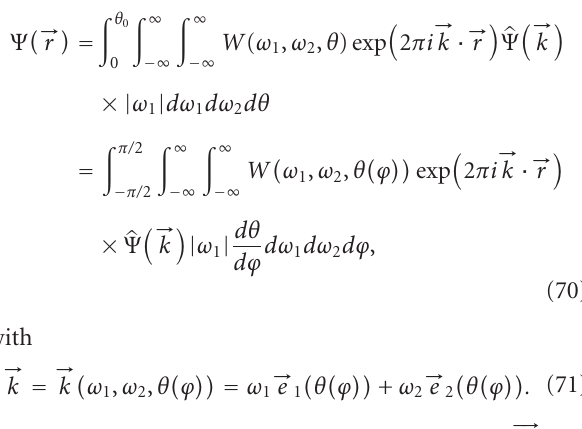
π/ 4, ϕ 3 = 0, ϕ 4 = π/ 4 and ϕ 5 = π/ 2, respectively. Note −−→ −−→ that the initial position Π ( OS 1 ) and the final position Π ( OS 5 ) coincide with each other. In Figure 7, the two curved sides of the red triangle on the −→ top of the unit sphere is the locus of e 3 , the instantaneous −−→ rotation axis of the frequency plane. Similarly, e 2 and −−→ Π ( OS 1 ) form the counterpart triangle on the bottom of the −→ unit sphere. The locus of e 2 is the division line of the regions −→ with di ff erent J ( k ) values. Based on (58), the total area of the two triangles is only 0.55% of the surface area of the unit sphere. −→ Note that a sharp point on the locus of e 2 appears at ϕ = ϕ 3 = 0 . The reason is as